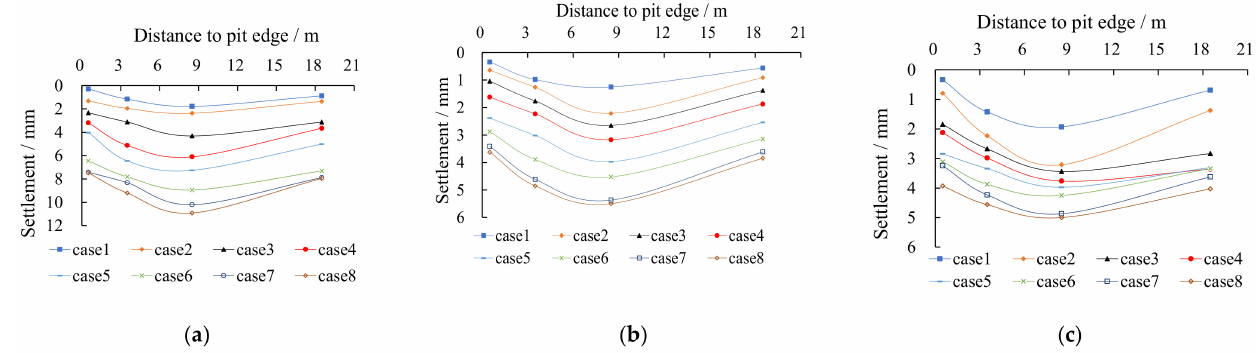
Figure 9. Distribution of ground settlement around pit under different case: ( a ) DBC-7, ( b ) DBC-33, ( c )